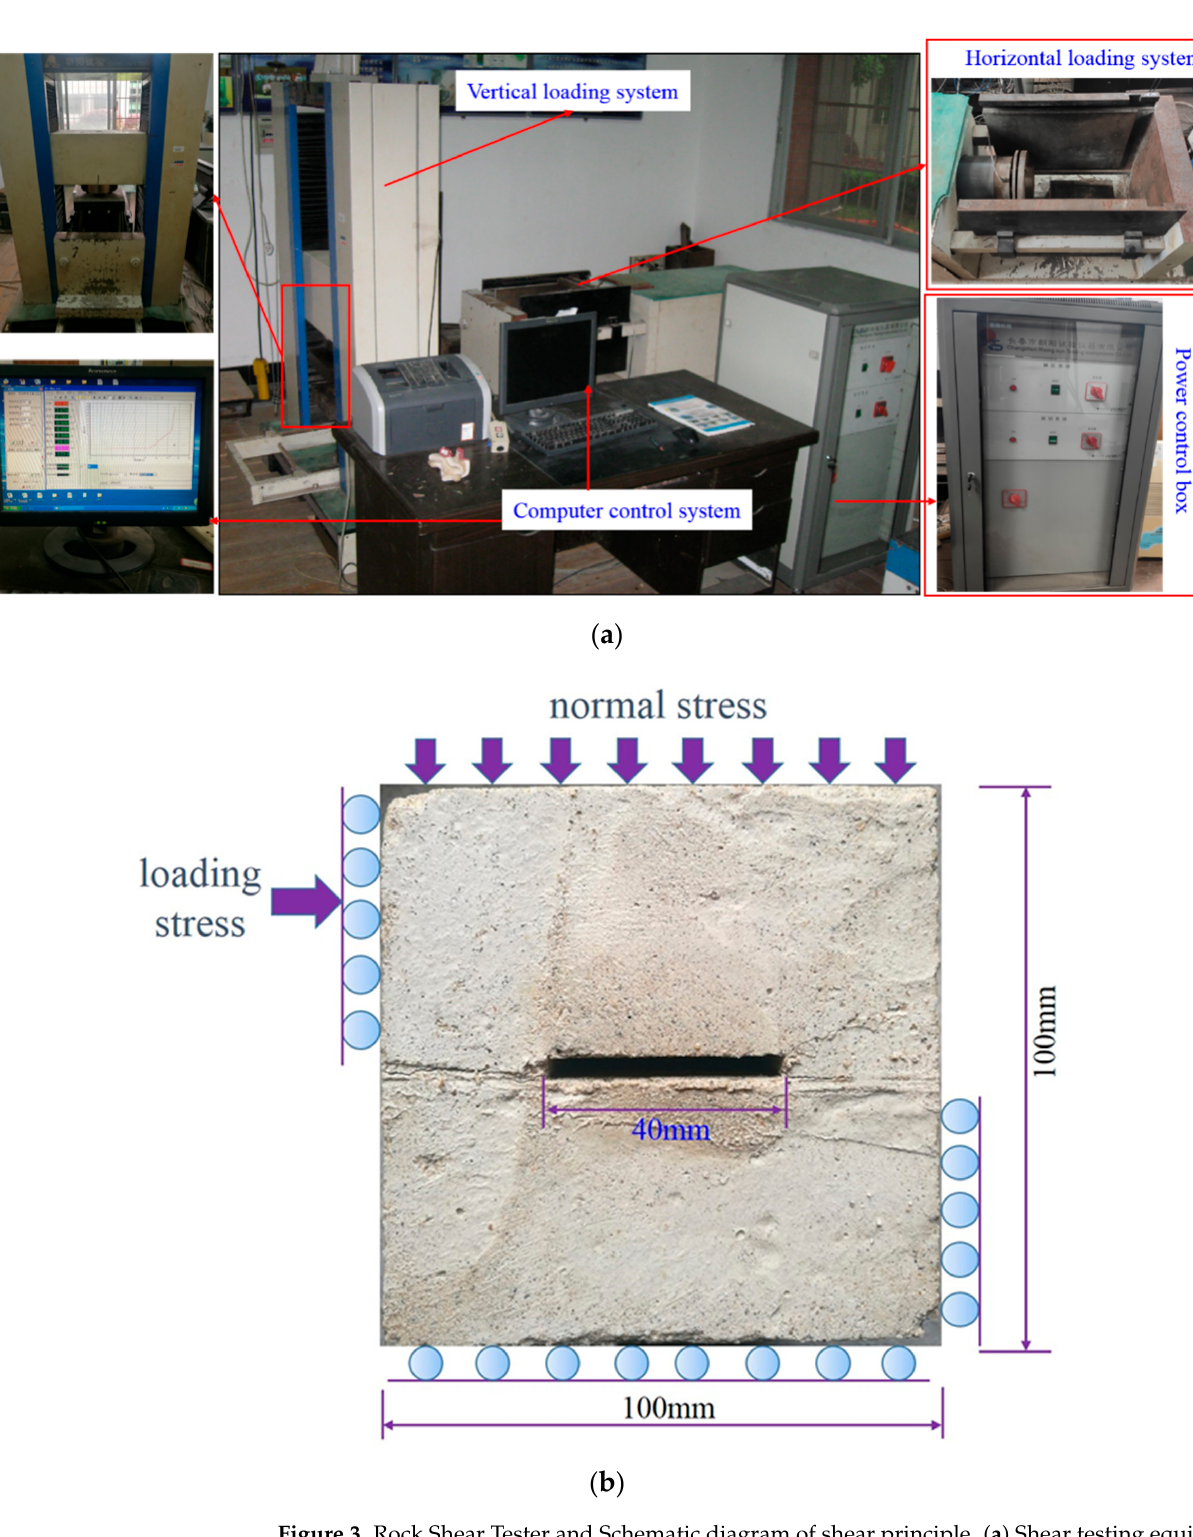
Figure 3. Rock Shear Tester and Schematic diagram of shear principle. ( a ) Shear testing equipment. ( b ) Schematic diagram of shearing of joint specimen.